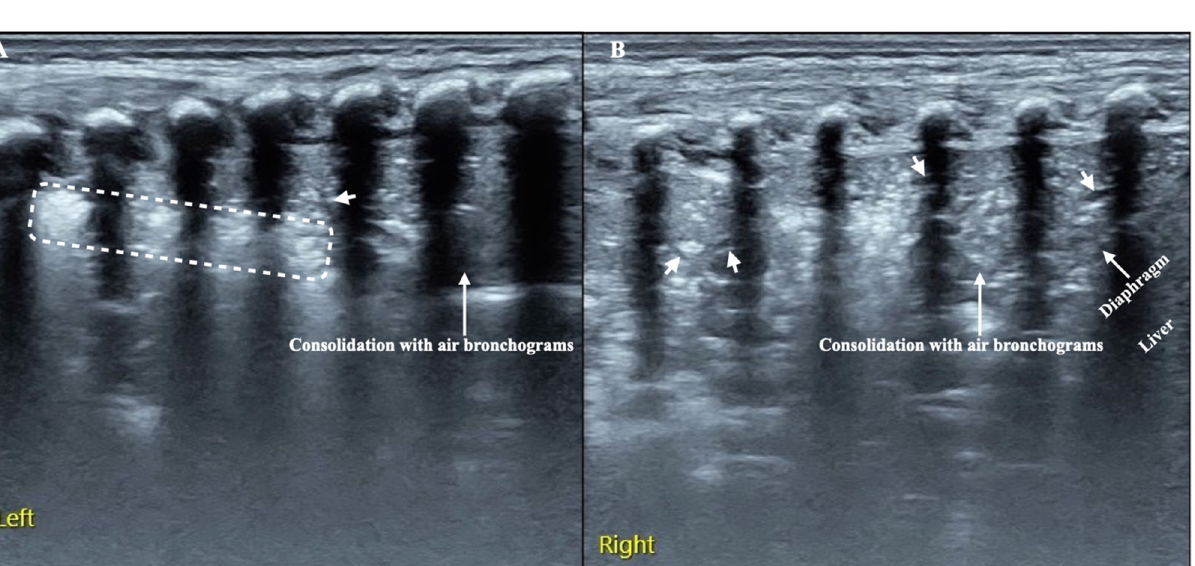
Figure 3. LUS manifestations of neonatal fungal pneumonia. It can be seen from the picture that the left lung mainly shows a few B-lines, suggesting the presence of mild lung edema. In the right lung, there was obvious consolidation with air bronchograms and shred signs in the subaxillary and pos- terior areas. Atelectasis was seen in the upper lung field of the right anterior chest. ( A ): the left anterior lung field, ( B ): the left subaxillary lung field and ( C ): the left posterior upper lung field. ( A1 ): the right anterior upper field, ( B1 ): right subaxillary upper lung field and ( C1 ): right posterior upper lung field.